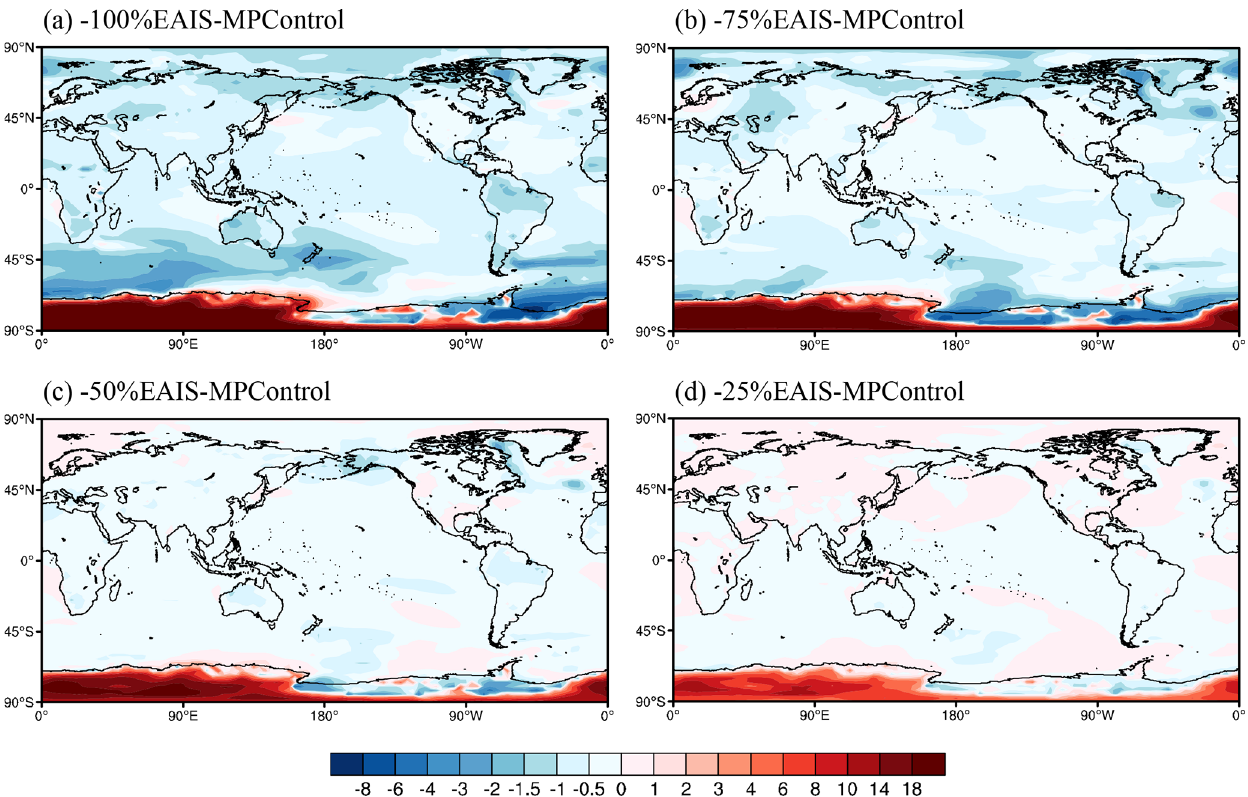
Figure 3. Spatial distribution of the annual mean surface air temperature anomalies (units: ◦ C) over the globe between sensitivity experiments and MPControl